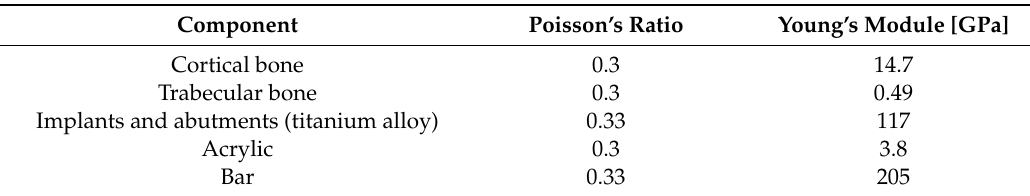
( b ) Figure 4. v on Mises stress on the implant, abutment, and metallic structure: (a) group M1; (b) group M2. 3. Results 3.1. Distribution Stress in Dental Implants In the M1 group, corresponding to four implants, the highest values of von Mises stress appeared around the bar where the implants were more rigid. The maximum stress on the implant was 148,92 MPa, while that on the bar was 70,5 MPa, as detailed in Figure 5.